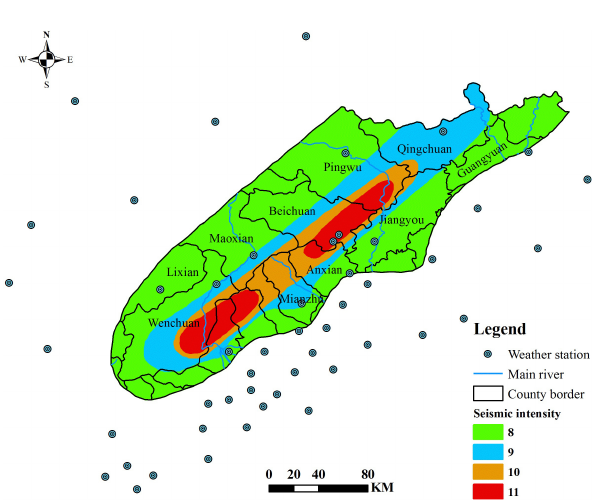
Figure 8. Distribution of weather stations in the earthquake-affected area and nearby